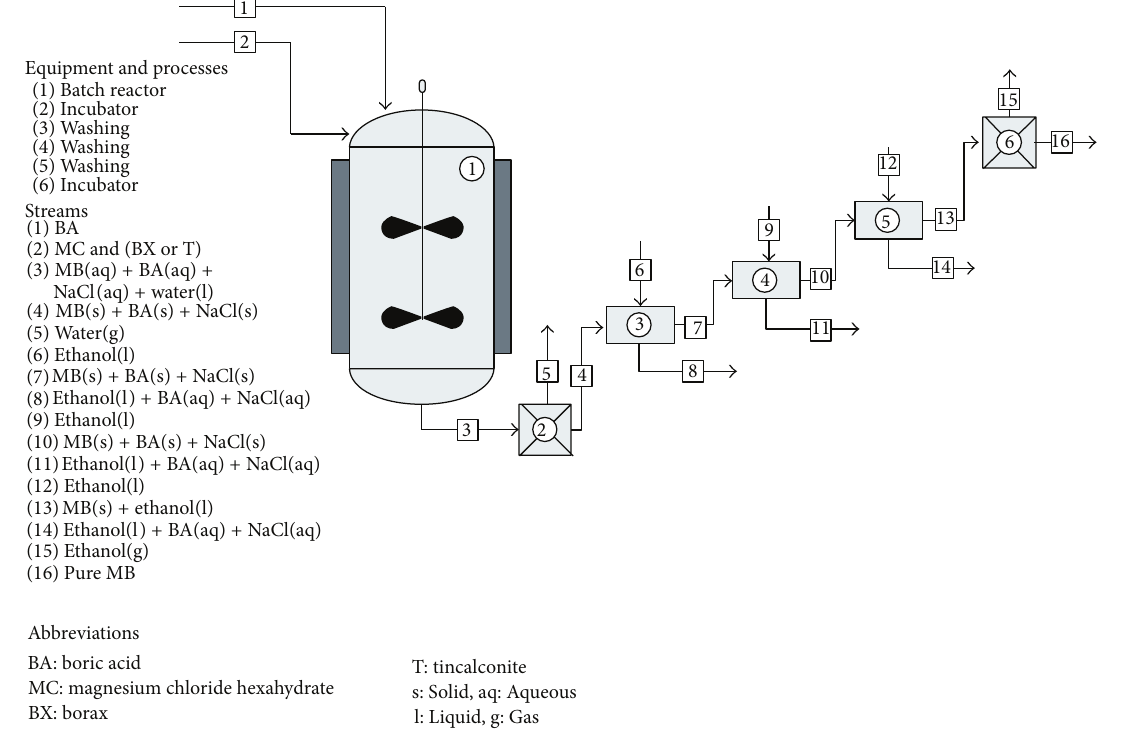
Figure 1: Schematic experimental